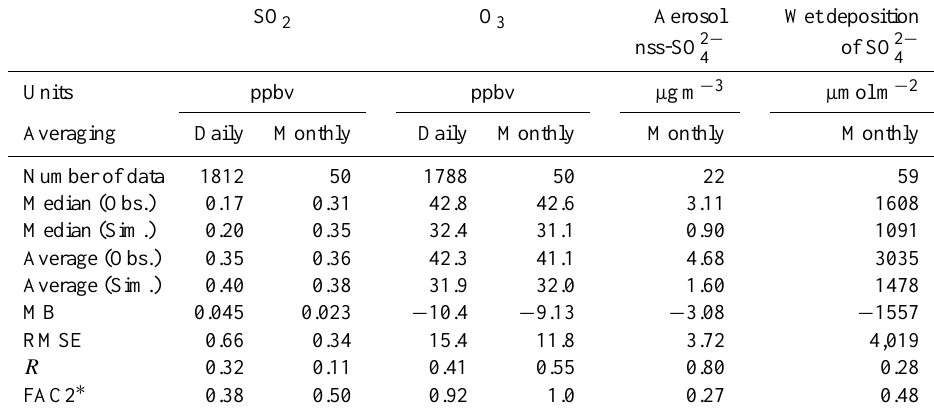
Table 2. Statistical analysis for comparisons between daily and monthly observations and simulation data at the six EANET remote stations. SO 2 O 3 Aerosol Wet deposition nss-SO 2 − of SO 2 − 4 4 Units ppbv ppbv µgm − 3 µmolm − 2 Averaging Daily Monthly Daily Monthly Monthly Monthly Number of data 1812 Median (Obs.)